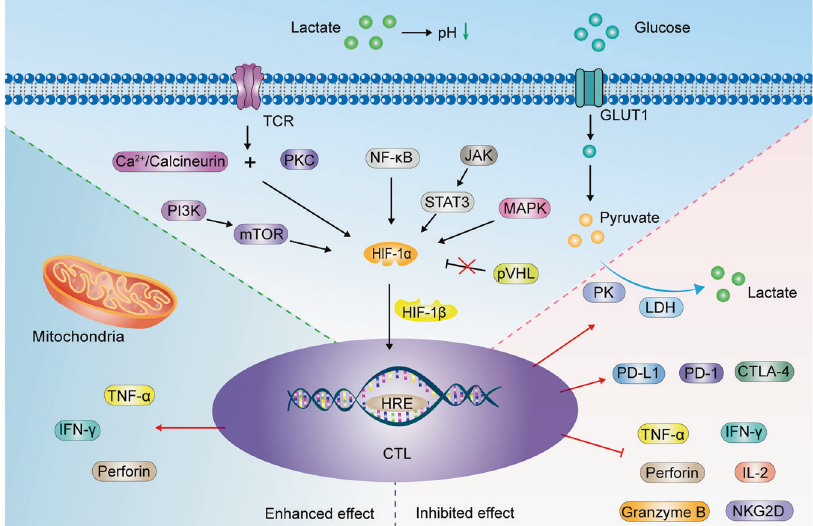
Fig. 5 Hypoxia remodels CTL immune effect. HIF-1 α in CTL is upgraded by TCR-PKC and Ca 2 + /calcineurin, PI3K/mTOR, NF- κ B, NF- κ B, JAK- STAT3, MAPK pathway. Deletion of pVHL impaired HIF-1 α degradation. HIF-1 α and HIF-1 β dimerization stimulates downstream factor expression, such as perforin, IFN- γ , TNF- α , which can enhance the antitumor ef fi cacy of CTL. However, some experiments elaborate the opposite results. Hypoxia inhibits the expression of IFN- γ , TNF- α , granzyme B, IL-2, perforin and NKG2D, while promoting PD-L1,PD-1 and CTLA-4 expression. CTL increases glucose uptake via GLUT1, which is metabolized to lactate by glycolytic enzymes PK and LDH. Lactate acidi fi es the TME, which inhibits CTL